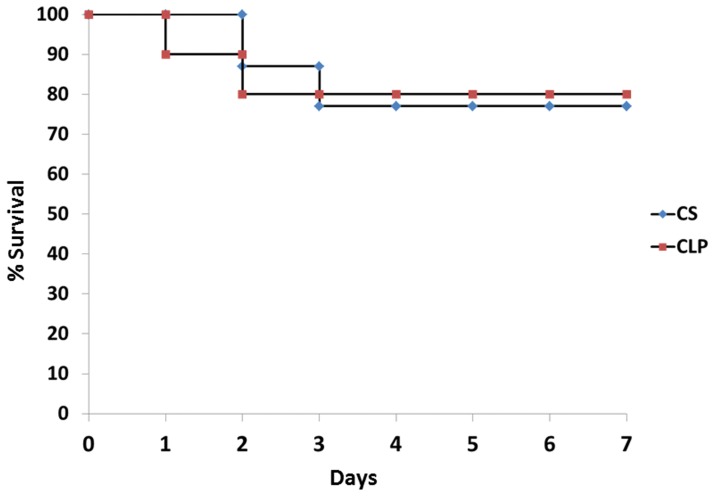
Survival responses to a cecal ligation and puncture (CLP) versus a cecal slurry (CS) model of polymicrobial sepsis.Survival was evaluated out to seven days. Mortality in the two models was similar. In the CS model, mice died on the second and third days, whereas, in the CLP model mice died on days one and two. (•- CS, ▪ - CLP).